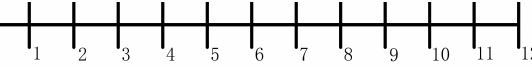
Figure 3. The 12 bus radial distribution system.